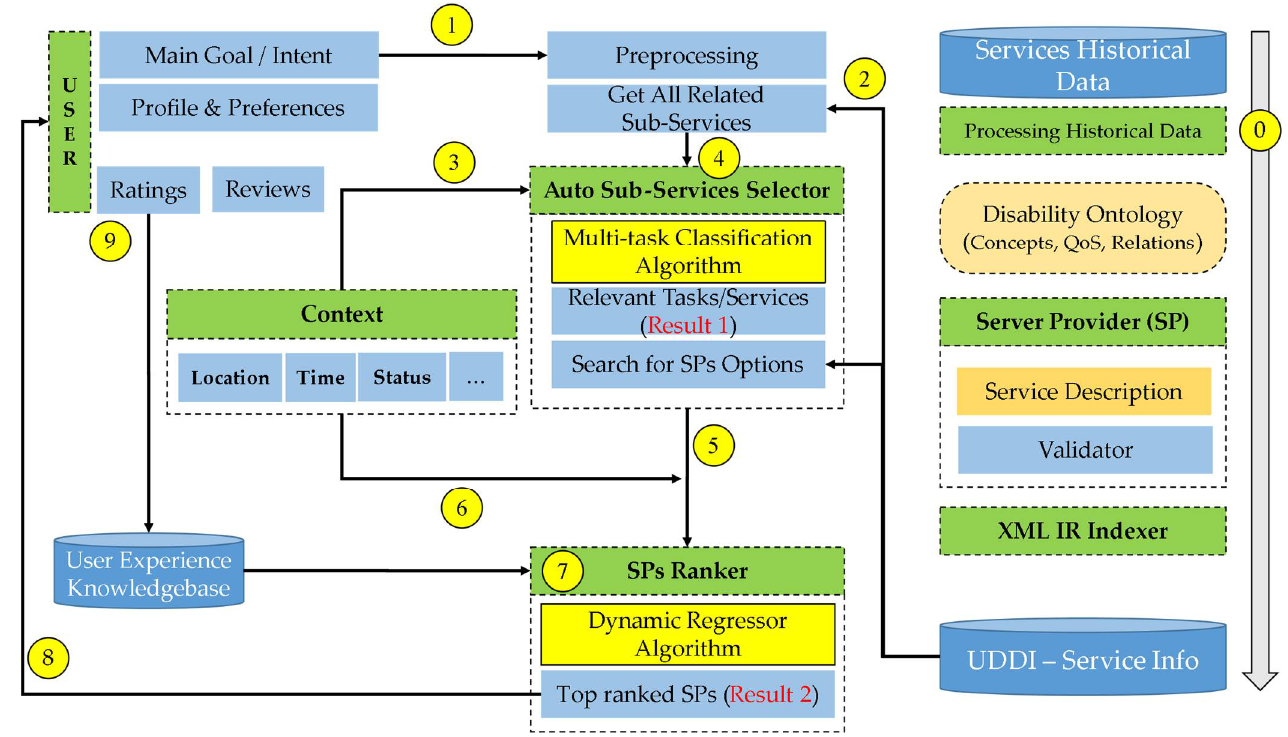
Figure 4. The proposed ML-driven service selection framework for people with special needs. Key components include the disability ontology, validator, UDDI, selector, ranker, and reviews knowledgebase.